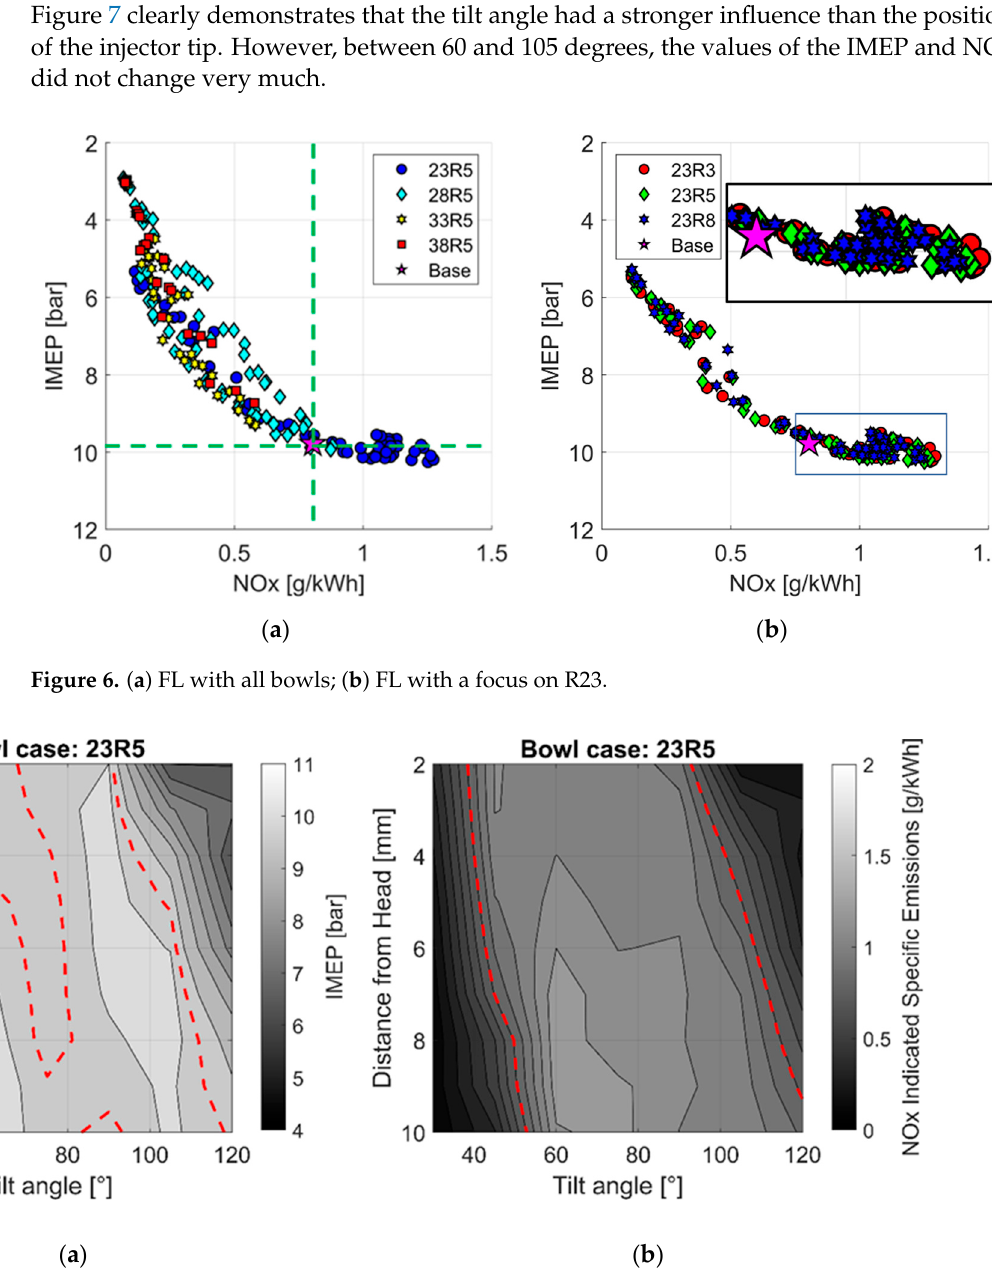
Figure 7. Bowl 23R5 IMEP ( a ) and a specific NO x plot with standard bowl isolines ( b ) .